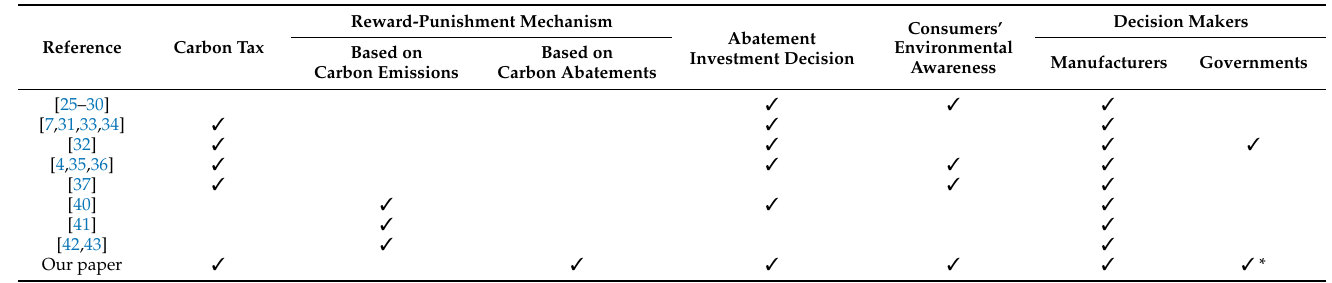
Table 1. Summary of relevant literature and the position of our paper.